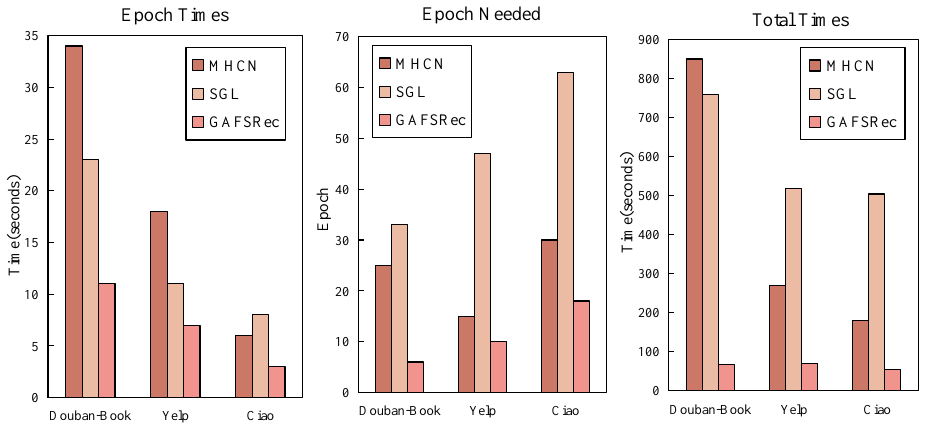
Figure 3. The training speeds of the compared methods.